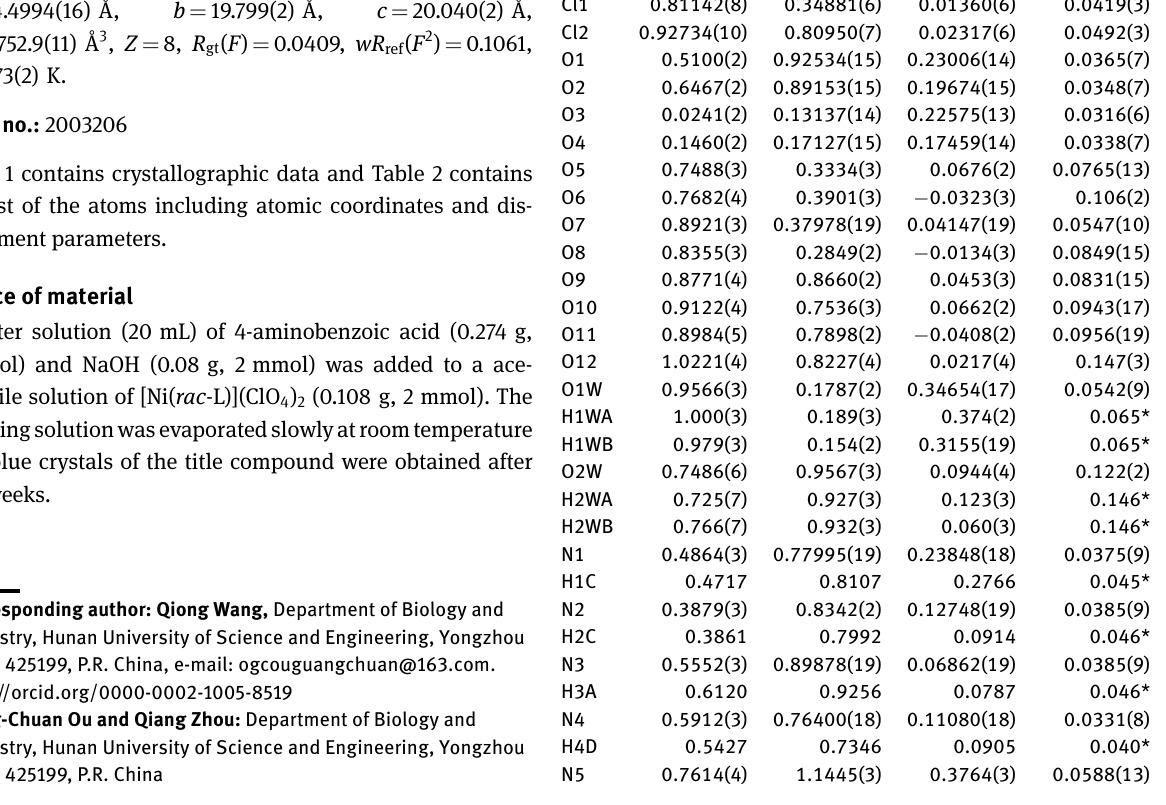
Table 1 contains crystallographic data and Table 2 contains the list of the atoms including atomic coordinates and dis- placement parameters.